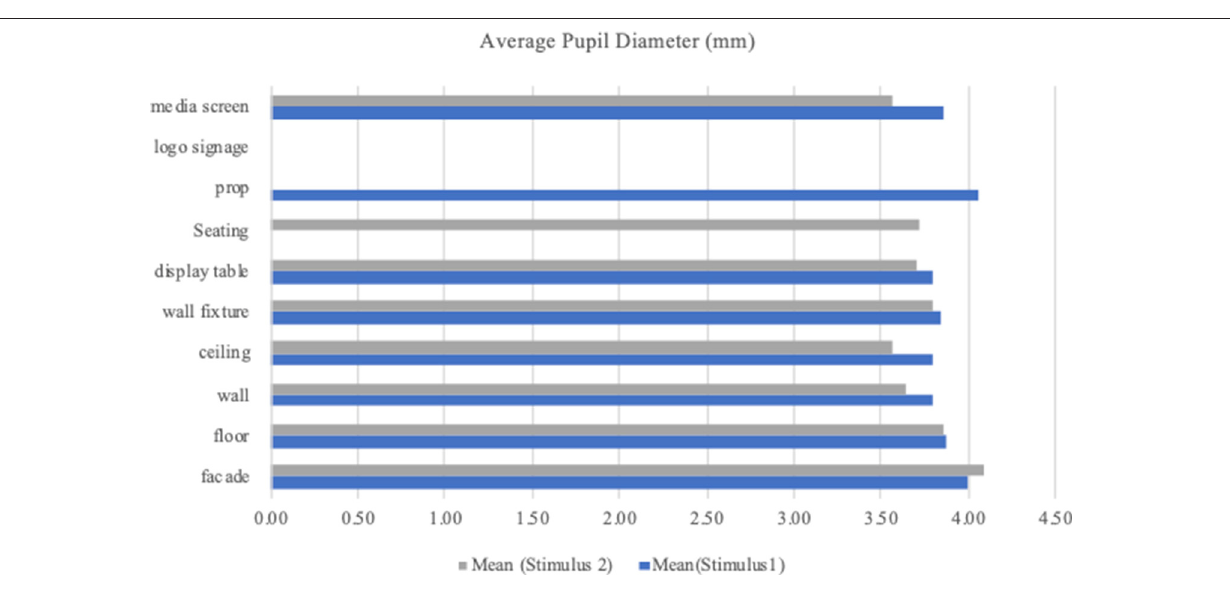
FIGURE 8 | Mean value of average pupil diameter per